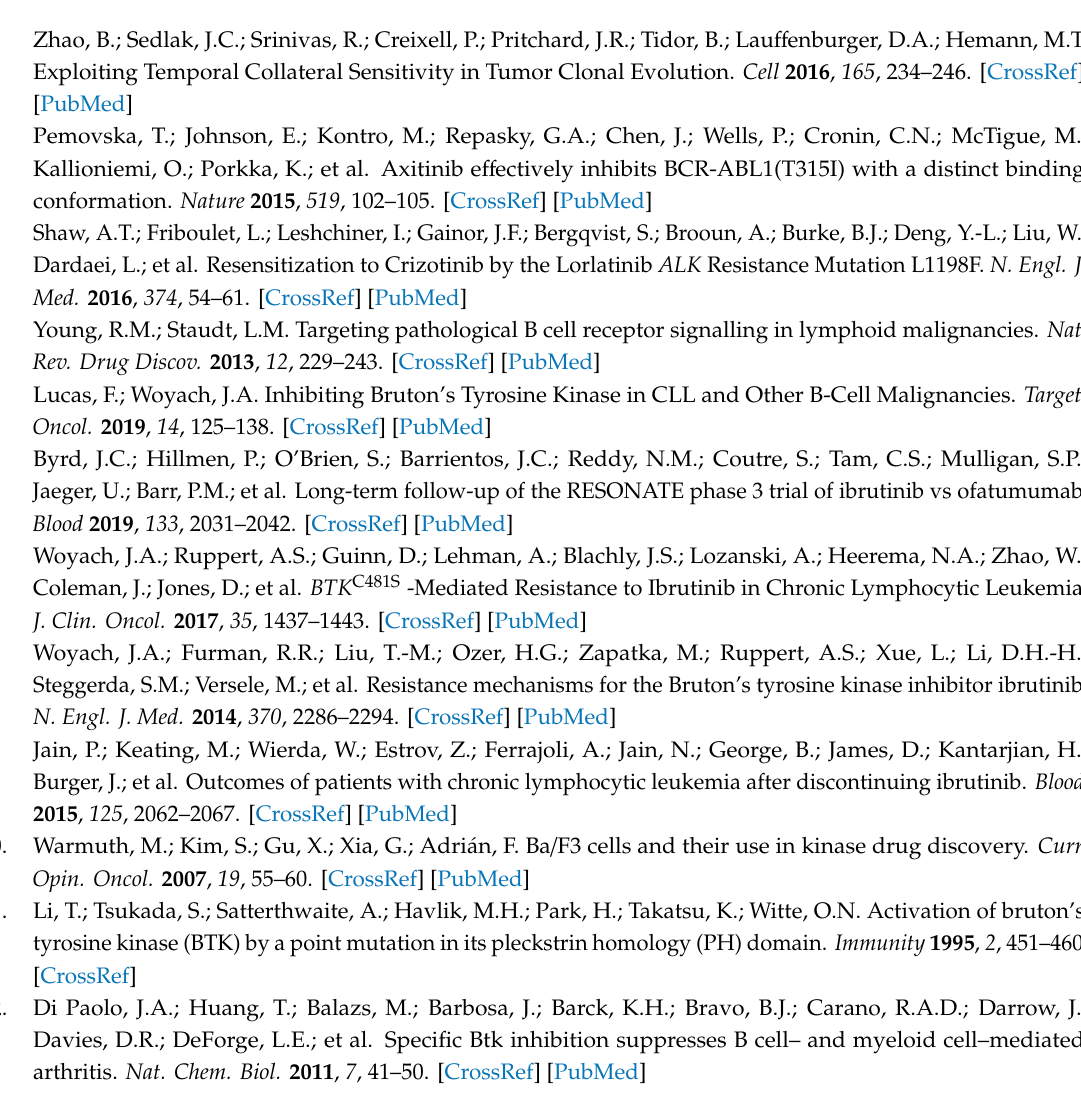
analysis. Table S1: results of the screens for all the 590 drugs contained in the library; Table S2: results of the screens for the BTK inhibitors contained in the